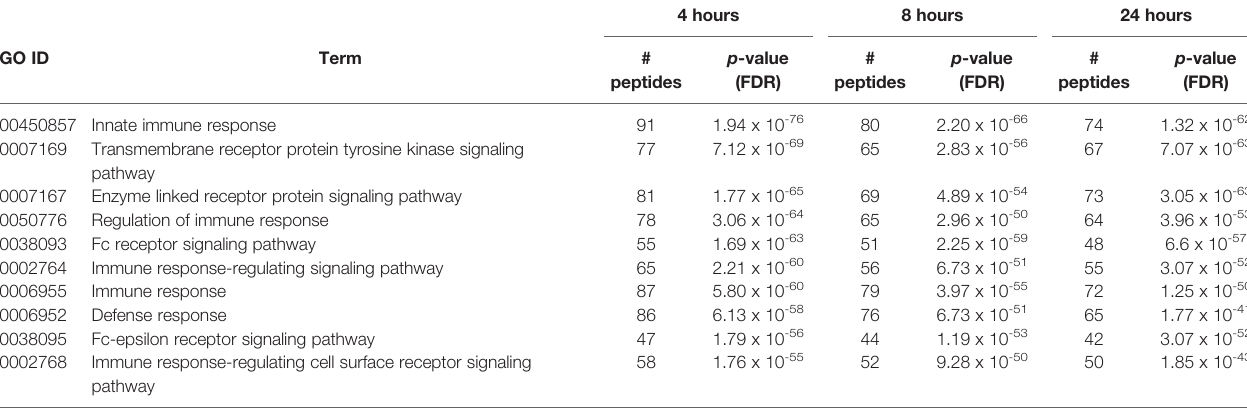
TABLE 2 | Top 10 GO Biological processes altered between the Salmonella -infected and noninfected groups at 4, 8 and 24 h post-infection from STRING analysis.